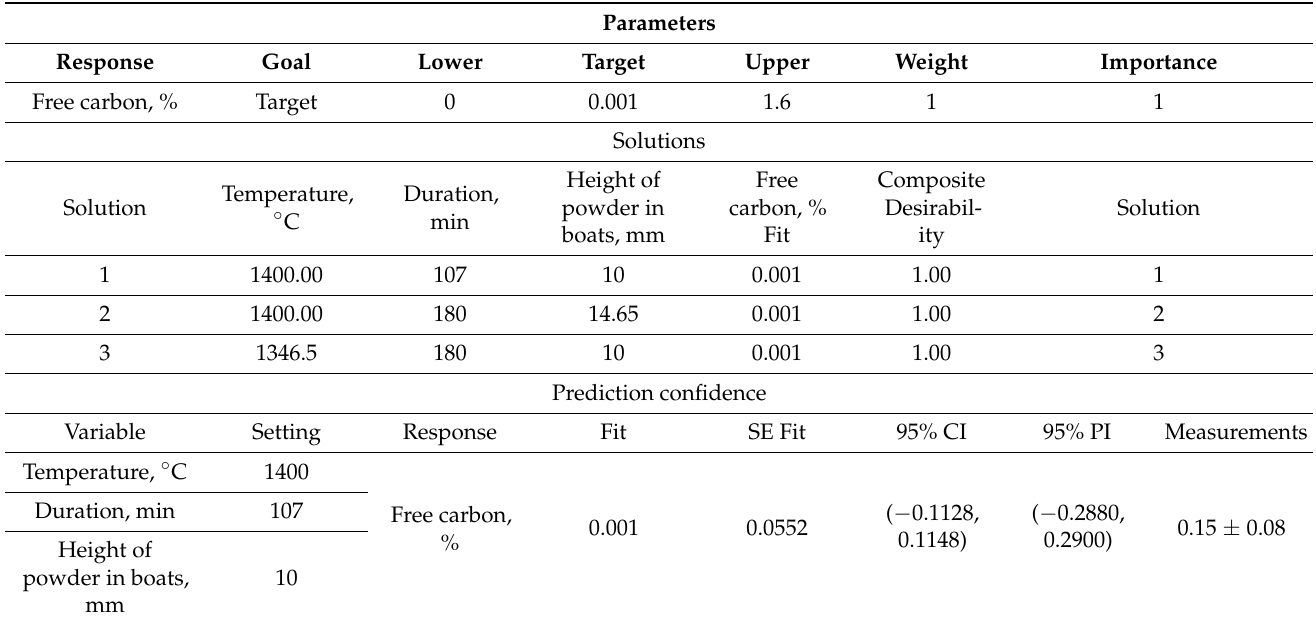
Table 3. Response optimization for WC carbidization based on the developed regression model. SE—standard error, CI—confidence interval, PI—prediction